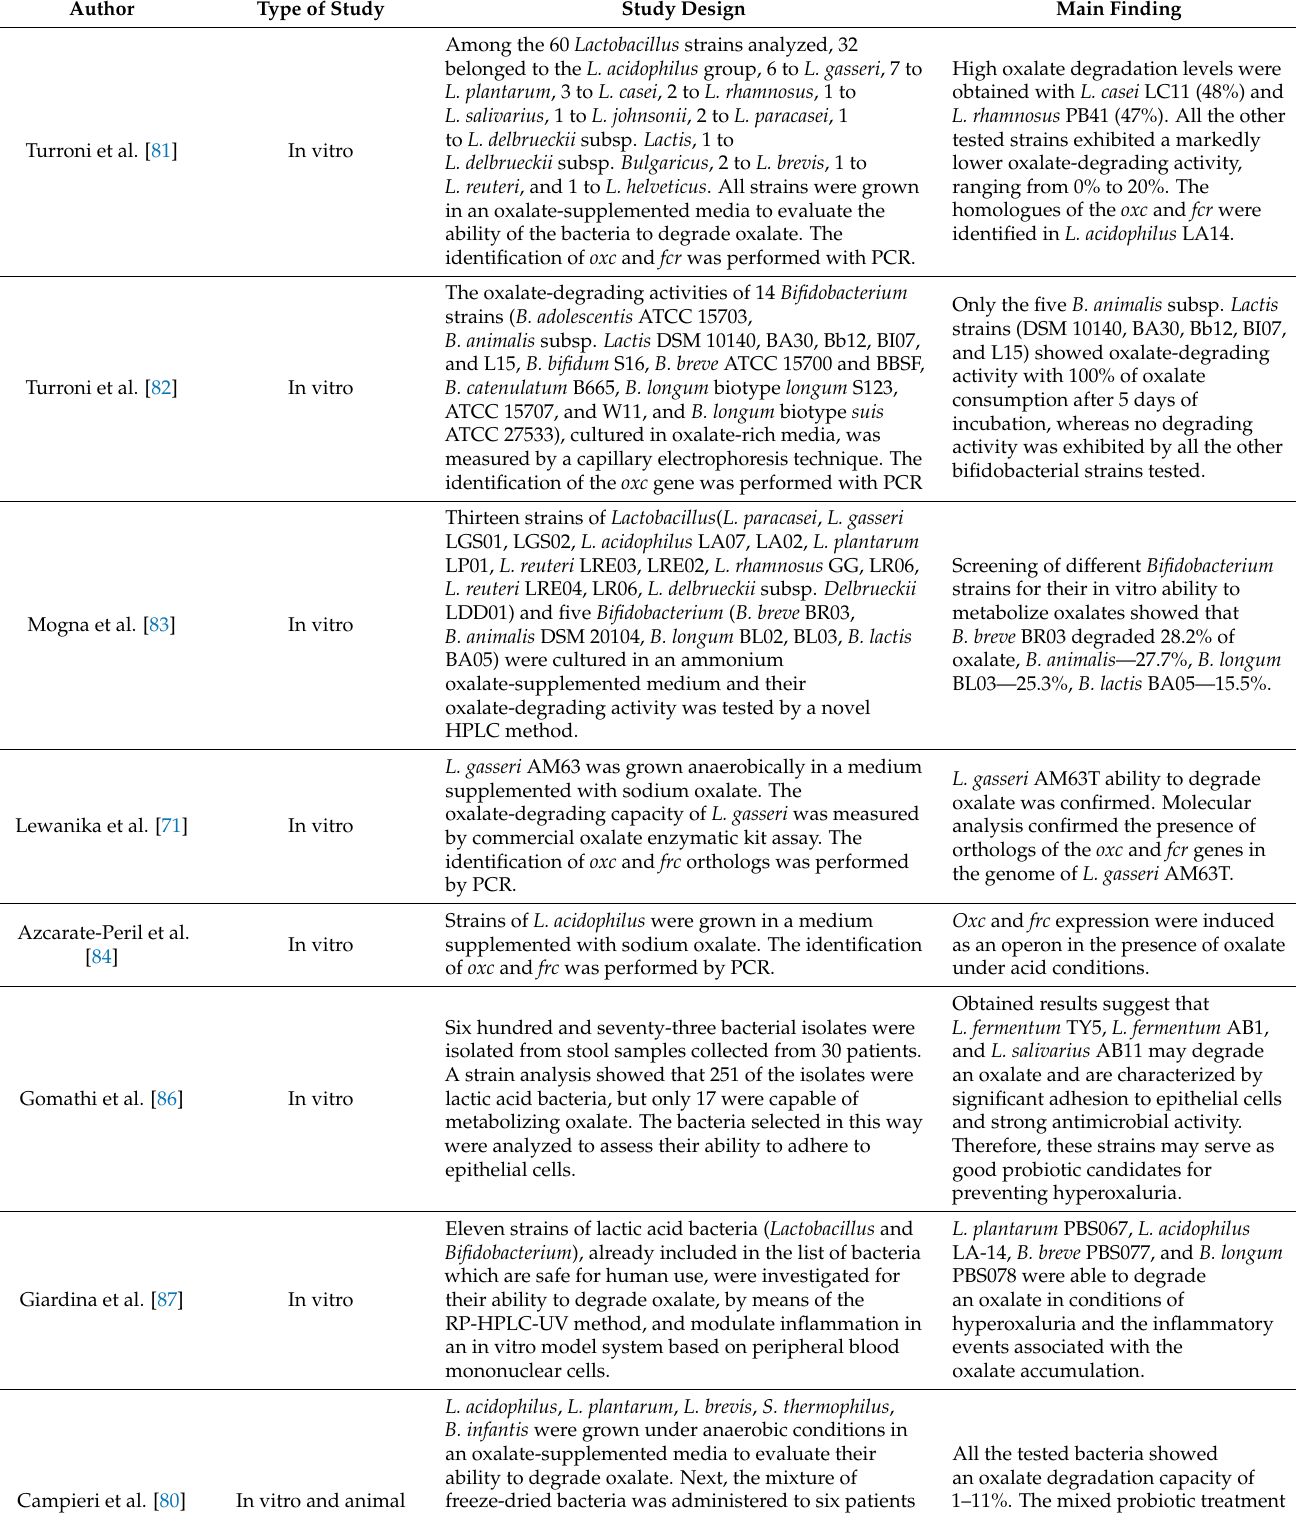
Table 5. A summary of previous studies on the use of Lactobacillus spp. for the prevention of